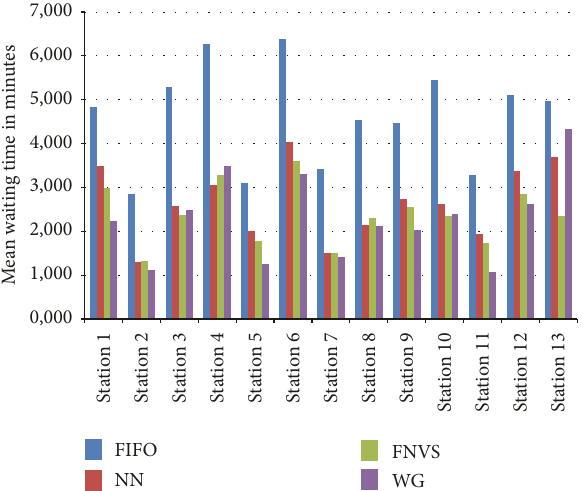
Figure 15: Wait time for each station with 300 vehicles.